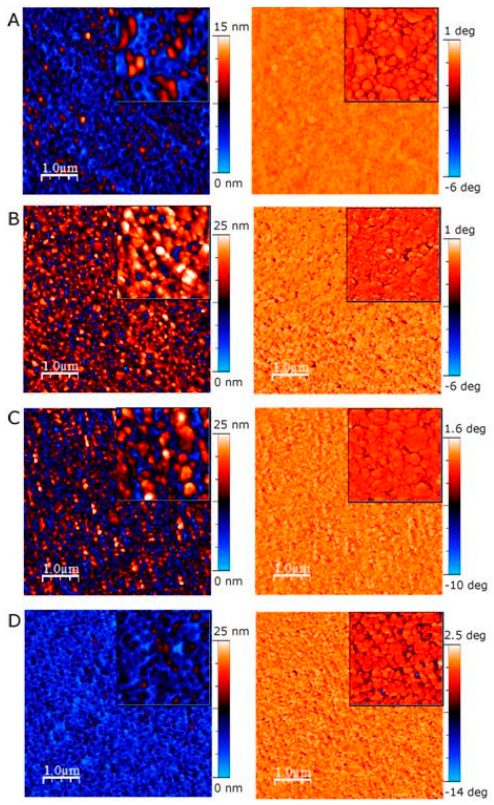
Figure 6. 5 μ m × 5 μ m TMAFM images (left: height images; right: phase images) of: ( A ) bare AcrA pp surface; ( B ) white wine; ( C ) rosé wine; and ( D ) red wine on ppAcrA. Inserts are 2 μ m × 2 μ m AFM images.